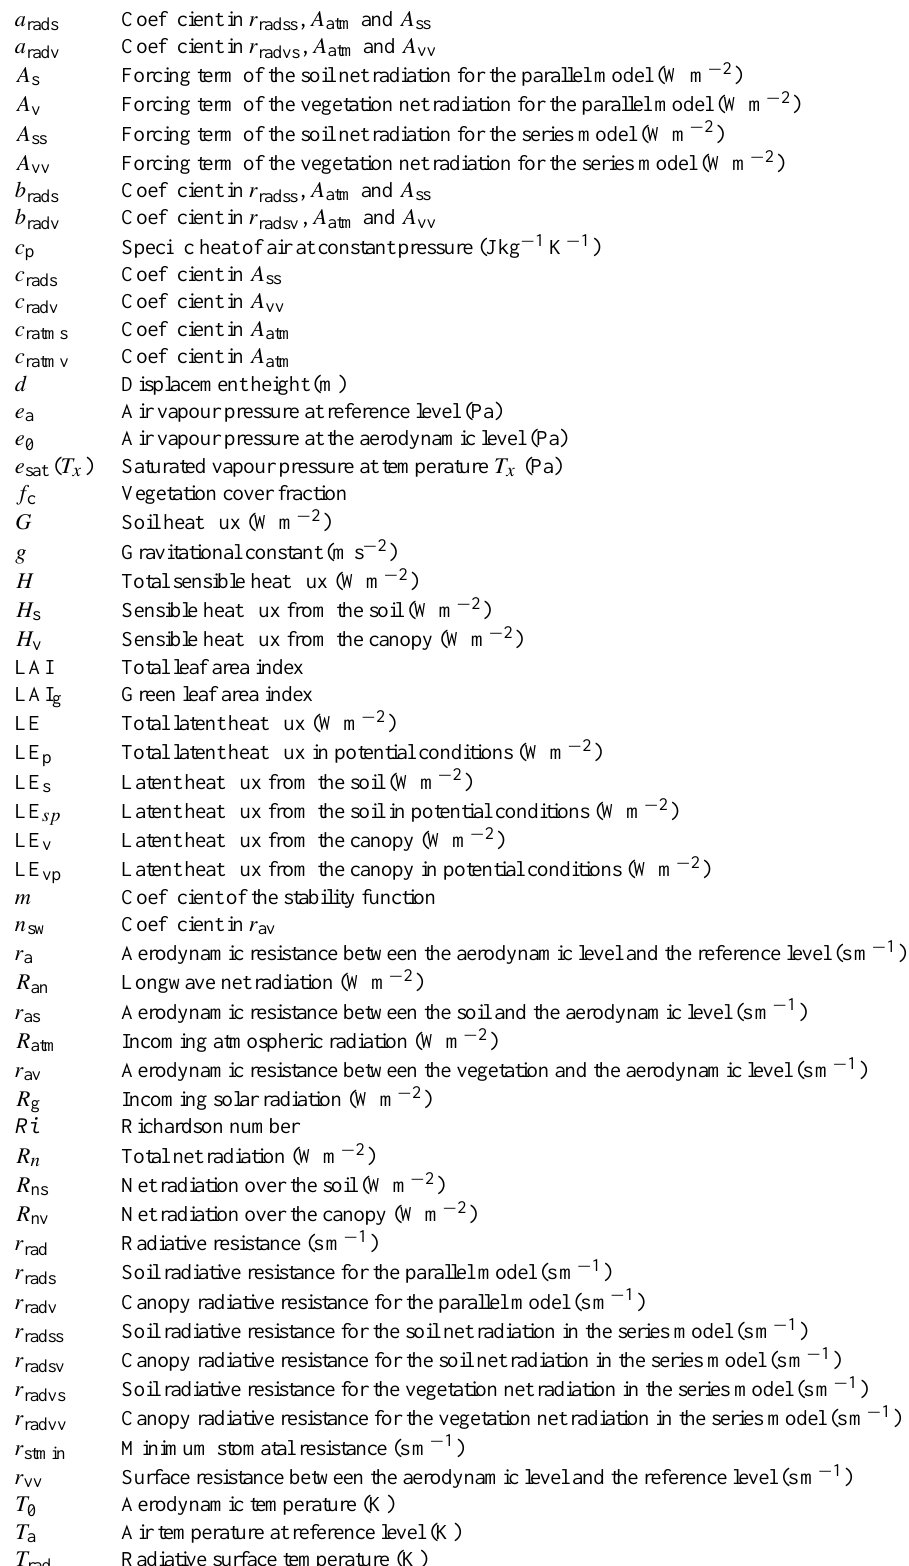
Table A1. Symbols. a rads Coefficient in r radss , A atm and A